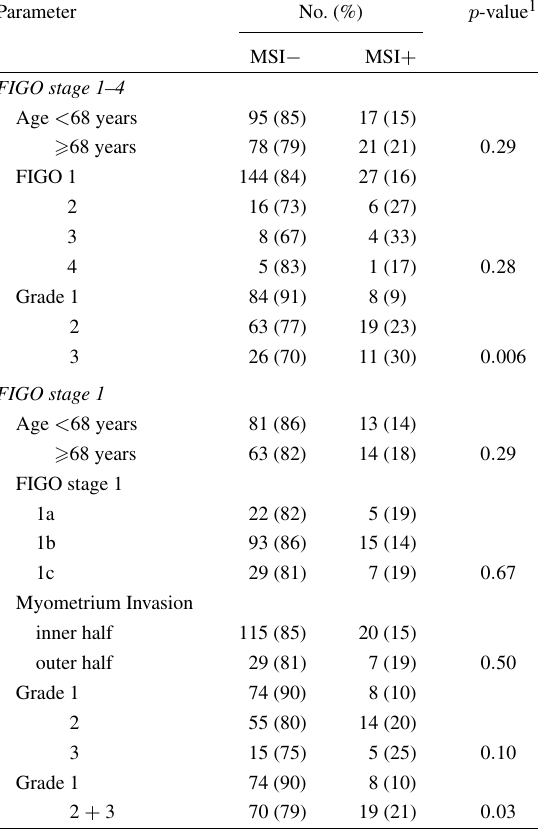
Associations between MSI and parameters analysed in endome- trial endometrioid cancer. MSS and MSI-L were classified as